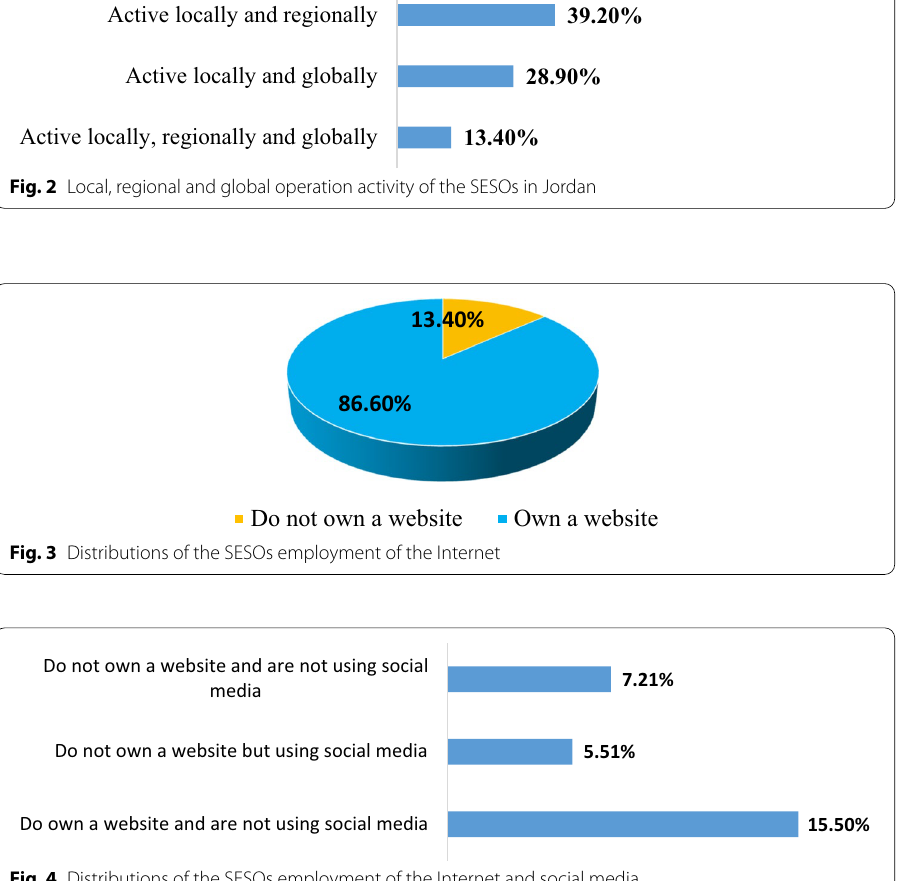
Fig. 4 Distributions of the SESOs employment of the Internet and social